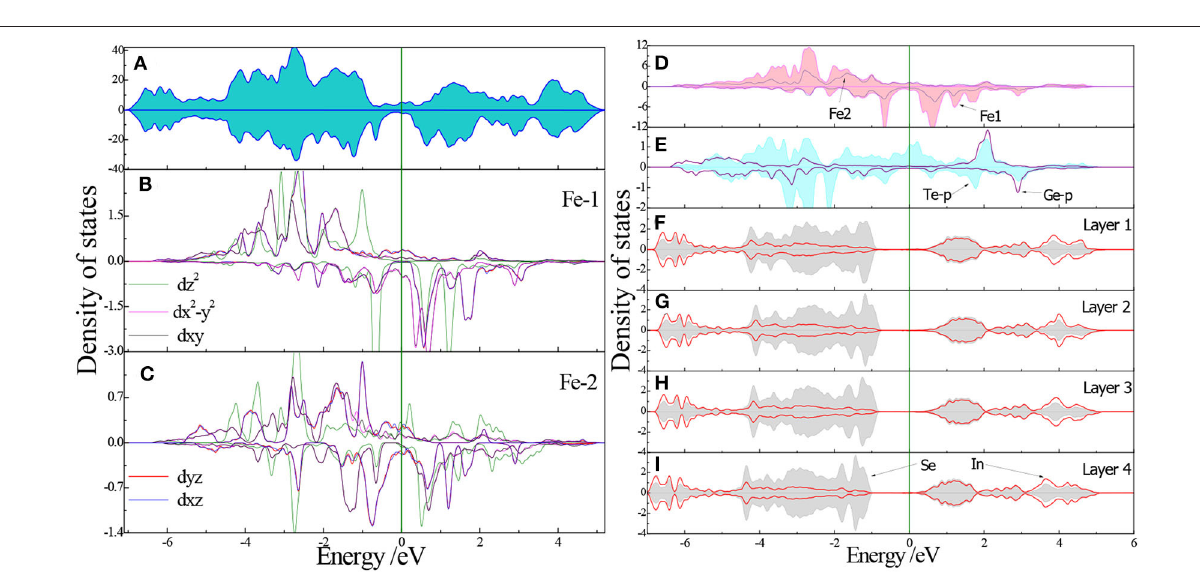
FIGURE 3 | Total DOS of the Fe 3 GeTe 2 /In 2 Se 3 HS for the – P case (A) ; the partial DOS of the five 3d orbitals for the four Fe1 (B) ; and two Fe2 atoms (C) ; the DOS of the inequivalent Fe1 and Fe2 atoms (D) ; the DOS of Te-5p and Ge-4p states (E) ; the layer-resolved DOS of the In 2 Se 3 layers (F–I)